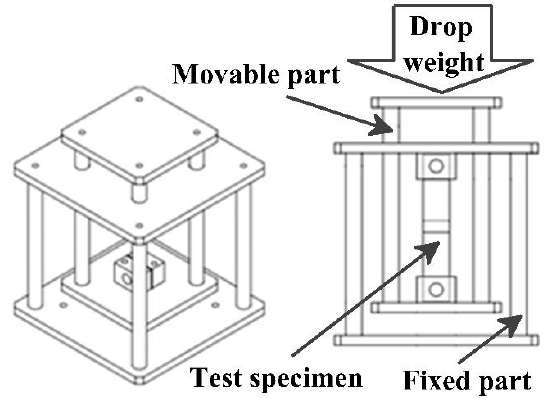
Figure 5. Fixture Design for Impact Test.